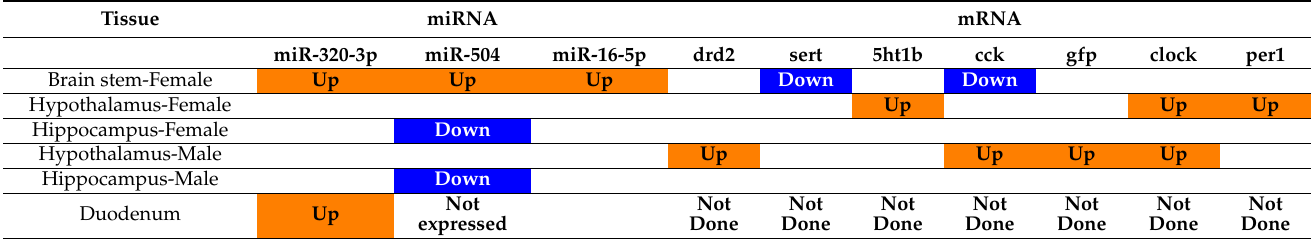
Table 1. List of significantly altered micro and messenger RNAs in the duodenum, brain stem, hippocampus, and hypothalamus of early weaned transgenic rat pups treated by a single oral supplement of miR-320-3p and sacrificed at Day-45. Note that the miR-375-5p level of w15-b320 was downregulated in comparison with w30-b320 ( p = 0.02), and w30-btem ( p = 0.04). No differences were found between genes assayed on the stomach. The orange or blue background underlines the up-or-down regulation of miRNA and mRNA,